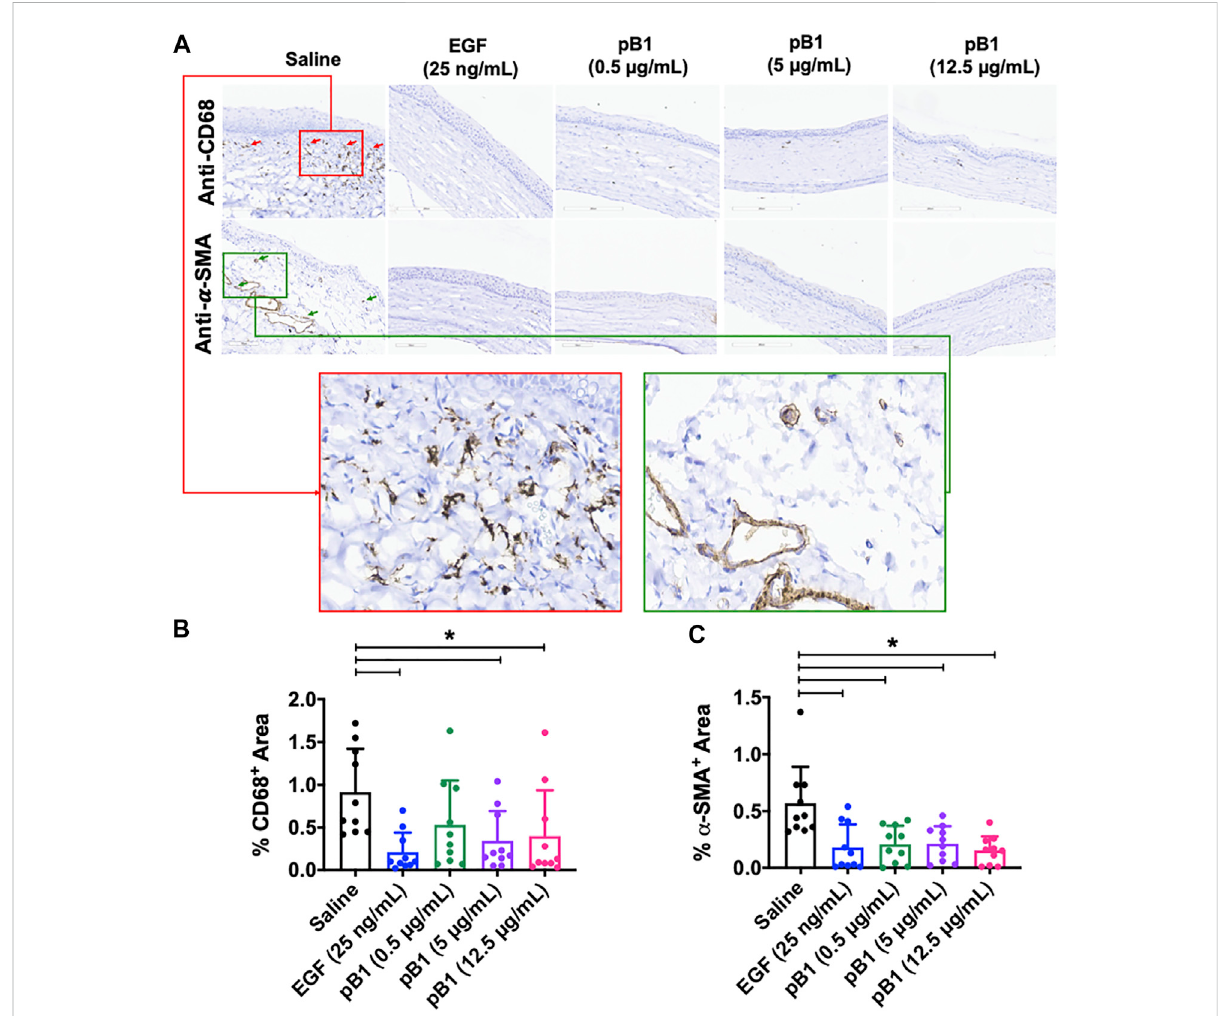
FIGURE 6 (A) Crosssectionsofcorneasharvestedat14 daysafterinjurywereimmunostainedwithantibodiesforCD68andalphasmoothmuscleactin( α - SMA) in order to identify macrophages and myo fi broblasts, respectively. Red boxed area represents the magni fi ed area with high level of positive CD68 staining. Green boxed area represents the magni fi ed area with high level of positive α -SMA staining (B,C) Bar charts demonstrating (B) the numberofCD68-positiveand (C) α -SMA-positiveareasofallcornealinjurygroups.Fivecornealinjurygroups:(1)salinecontrol(10rats),(2)EGF (25 ng/ml; 10 rats), (3) pB1 (0.5 μ g/ml; 10 rats), (4) pB1 (5 μ g/ml; 10 rats), and (5) pB1 (12.5 μ g/ml; 10 rats). All results were expressed as the mean ± standard deviation (SD); *: p < 0.05 for all treated groups, as compared with the saline control group. Notes: EGF, epidermal growth